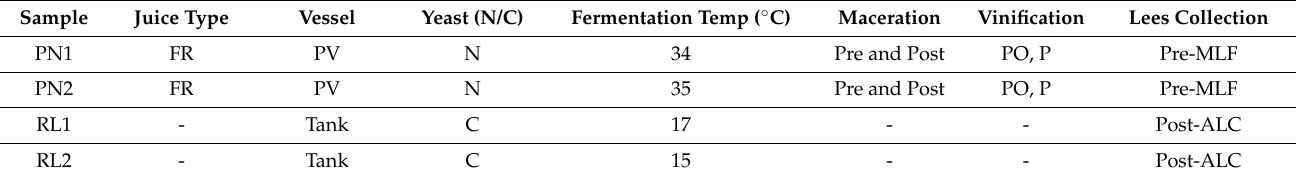
Table A1. Summary of vinification used for PN and RL